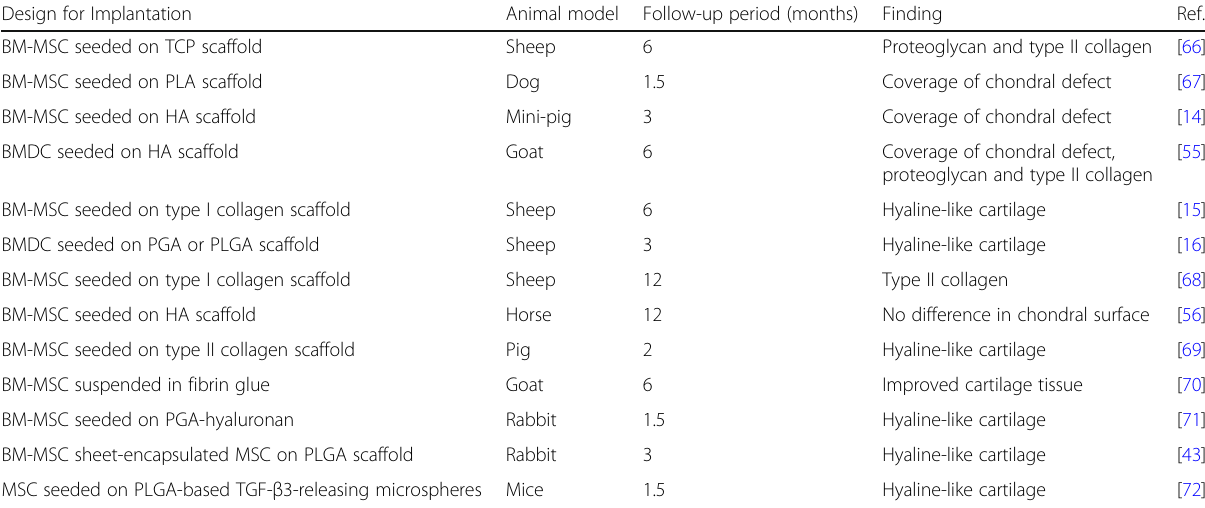
Table 1 Application of MSC seeded onto various types of scaffolds into animal models of articular cartilage defect Design for Implantation Animal model Follow-up period (months) Finding